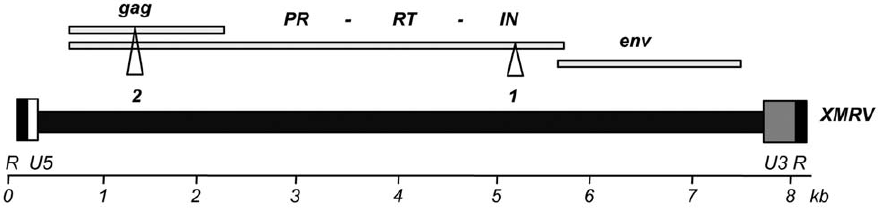
Figure 1. Primer and probe positions on the XMRV genome. Diagram of the XMRV genome with the sites of the primers marked.